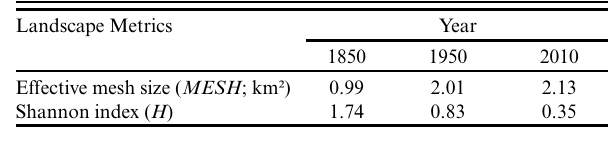
Table 2 . Effective mesh size and Shannon index for 1850, 1950, and